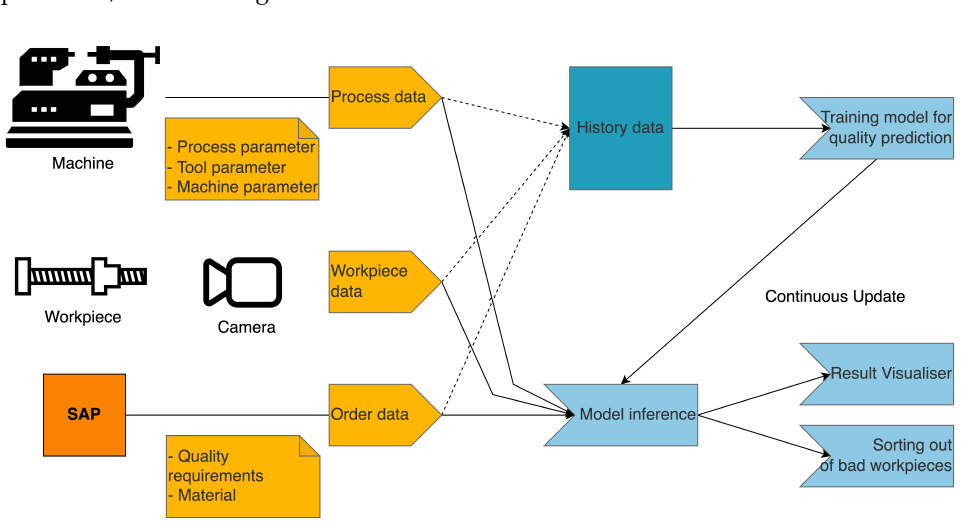
Figure 4. Visual Metal Surface Quality